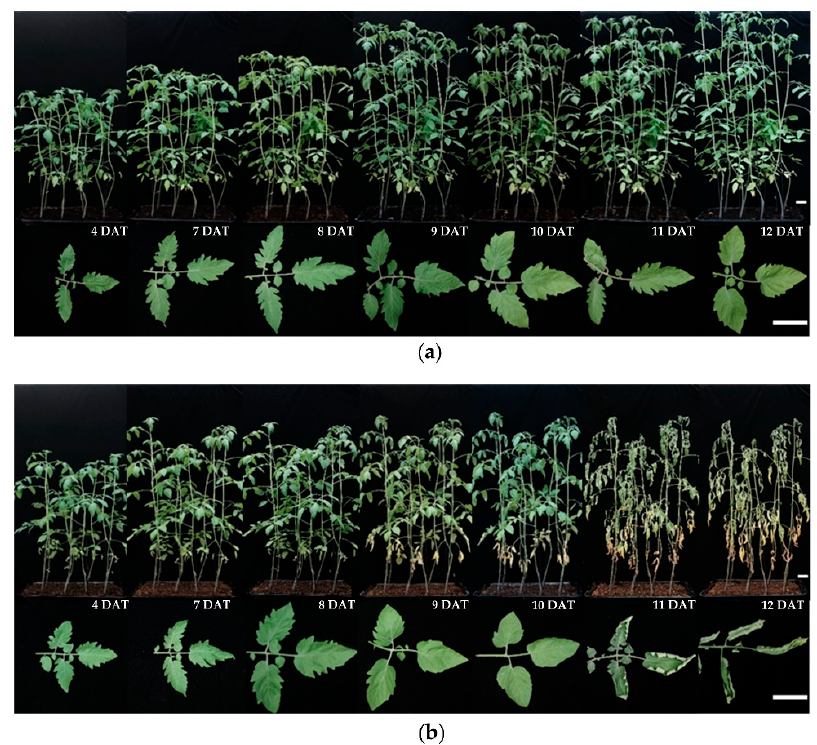
Figure 4. Morphological alterations from 4 to 12 days after treatment (DAT) in different treatment groups: ( a ) regular irrigation treatment and ( b ) drought treatment (bar = 5 cm).